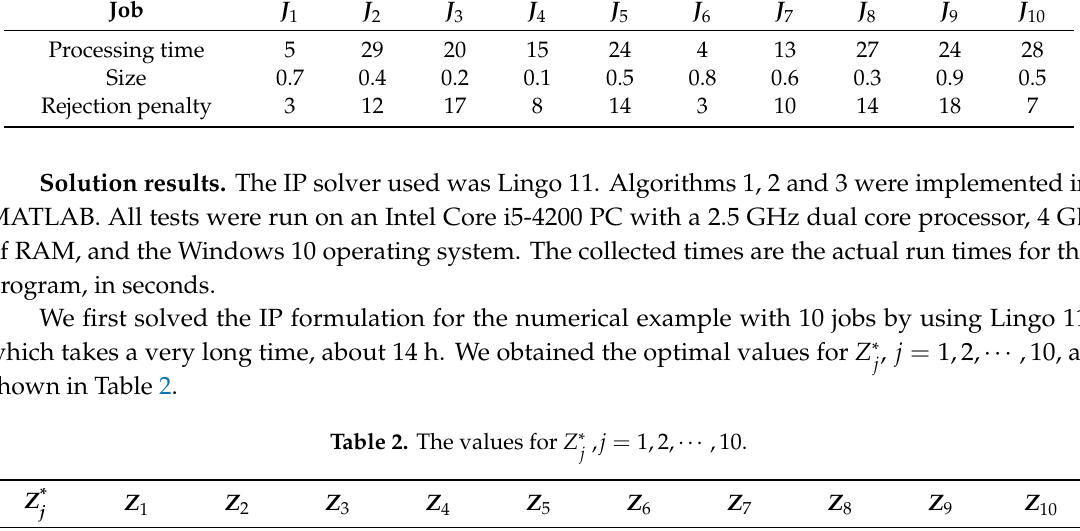
Table 2. The values for Z ∗